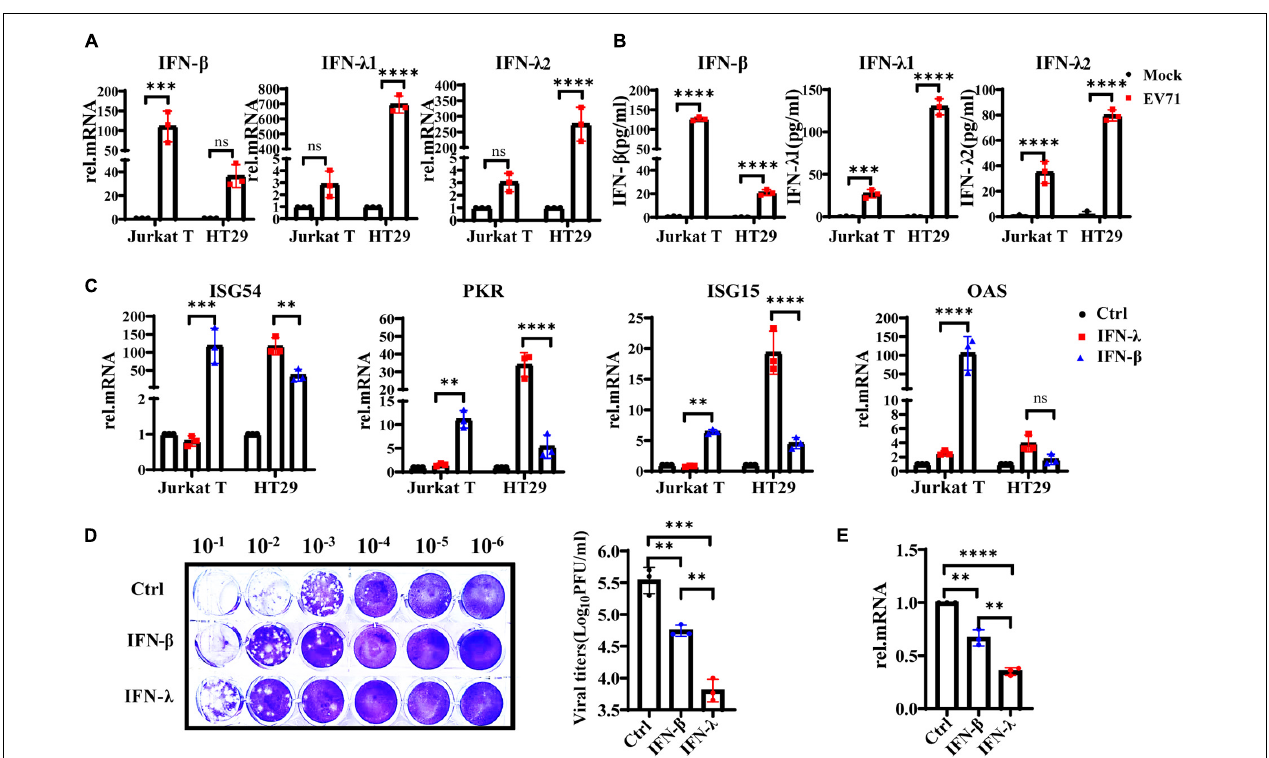
FIGURE 2 | IFN- λ effectively inhibits EV71 infection in intestinal epithelial cells. (A) HT29 and Jurkat T cells were uninfected or infected with EV71 at an MOI of 1, qRT-PCR was used to detect transcriptional upregulation of both IFN- β , IFN- λ 1, and IFN- λ 2 at 48 hpi. (B) At the same infection conditions, the production and secretion of IFN- β , IFN- λ 1, and IFN- λ 2 proteins in the supernatant were detected by ELISA. Mock was cells without infection. (C) HT29 and Jurkat T cells were stimulated without or with 10 ng/ml recombinant protein IFN- β or IFN- λ 1 for 12 h. Then the expression levels of ISG54, ISG15, PKR, and OAS were measured by qRT-PCR. Calculated the expression level of each gene relative to the expression of GAPDH and normalized it to mock-treated cells. Control was cells without treatment. (D,E) HT29 cells were pretreated with 10 ng/ml IFN- λ or 10 ng/ml IFN- β for 6 h, respectively, and then infected with EV71 at MOI of 1 for 24 h. The virus replication was monitored by qRT-PCR and plaque experiments. Control was cells with infected but without IFN treatment. Dates were presented as mean ± SD of three replicates ( n = 3 independent experiments, ∗∗ P < 0.01, ∗∗∗ P < 0.001, ∗∗∗∗ P < 0.0001 and ns, not